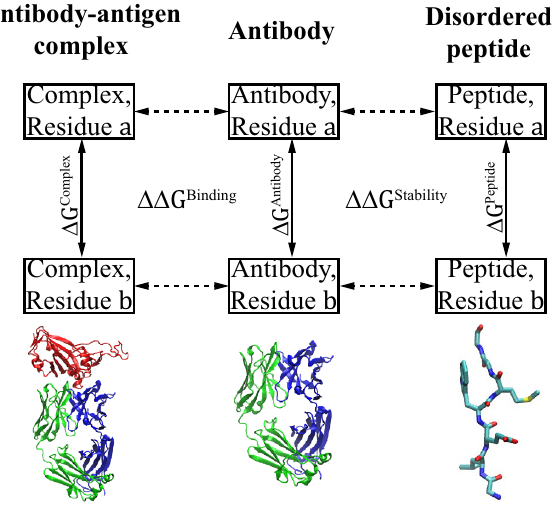
Figure 1. Schematics for the FEP calculations in this study. The free energy differences (cid:31) G Complex , (cid:31) G Antibody , and (cid:31) G Peptide between systems with residues a and b are obtained from the corresponding FEP simulations, and the results further determine (Eqs. (1) and (2)) the effect of mutation on the binding ( (cid:31)(cid:31) G Binding ) and the stability ( (cid:31)(cid:31) G Stability ) of the antibody. The illustrated protein structures are from the m396 antibody 25 , rendered by the VMD program 43 (version